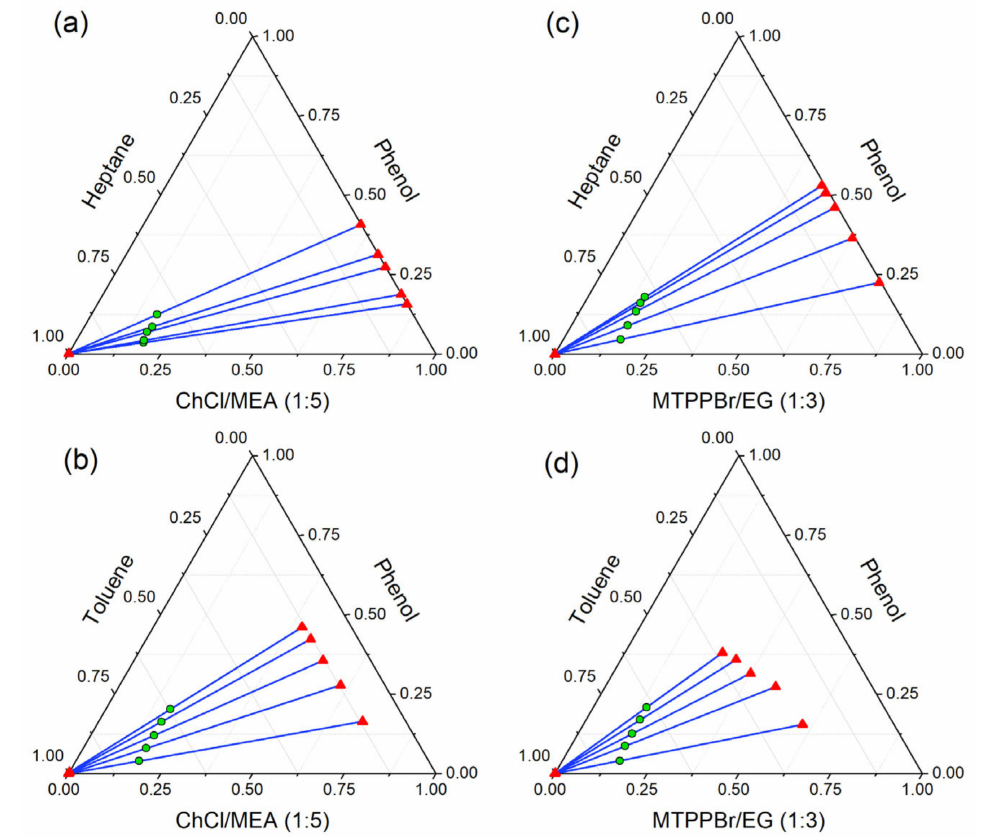
Figure 9. Ternary liquid–liquid equilibrium diagram in mole fraction for ( a ) heptane (1) + phenol (2) + ChCl/MEA (1:5) (3); ( b ) heptane (1) + phenol (2) + MTPPBr/EG (1:3) (3); ( c ) toluene (1) + phenol (2) + ChCl/MEA (1:5) (3); and ( d ) toluene (1) + phenol (2) + MTPPBr/EG (1:3) (3). For ternary systems including {toluene/heptane + phenol + MTPPBr/EG (1:3)} and {toluene/heptane + phenol + ChCl/MEA (1:5)}, the plots of D and S are shown